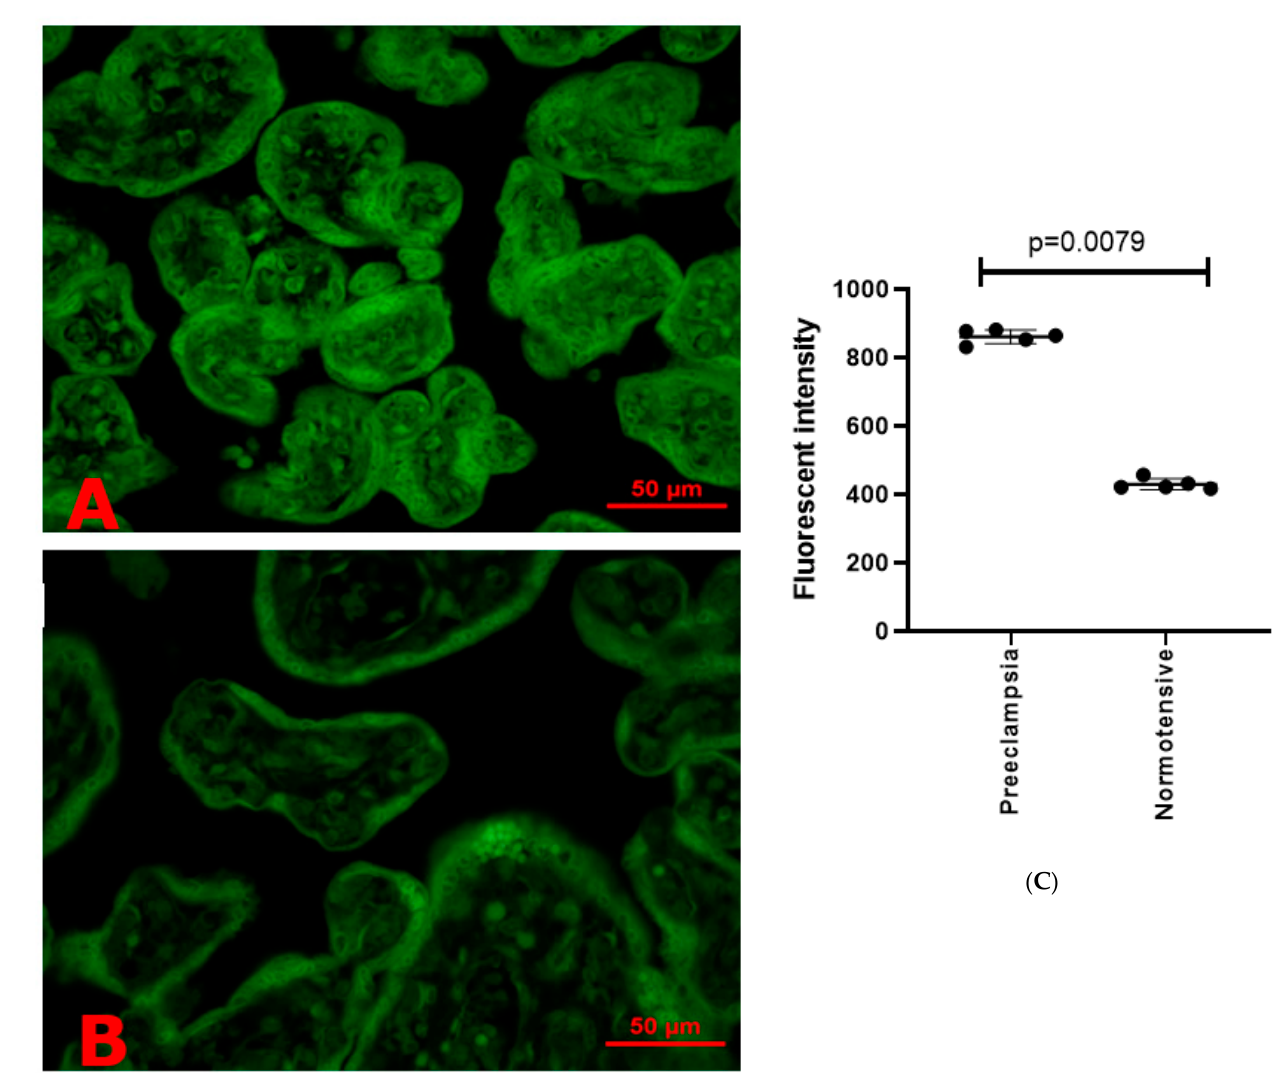
Figure 4. The levels of misfolded proteins in preeclamptic placentae, especially in the syncytiotrophoblast ( A ) and in normotensive term placentae ( B ), were measured by ThT fluorescent intensity. The statistical difference was confirmed by a semi-quantitative assay ( C ).